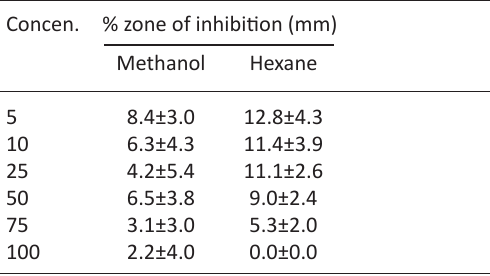
Table 13. Results obtained from the ANOVA analysis for methanol and hexane extracts for M. oleifera at 100%, 75%, 50%, 25%, 10% and 5% concentration against K. pneumoniae ANOVA Source of Variation